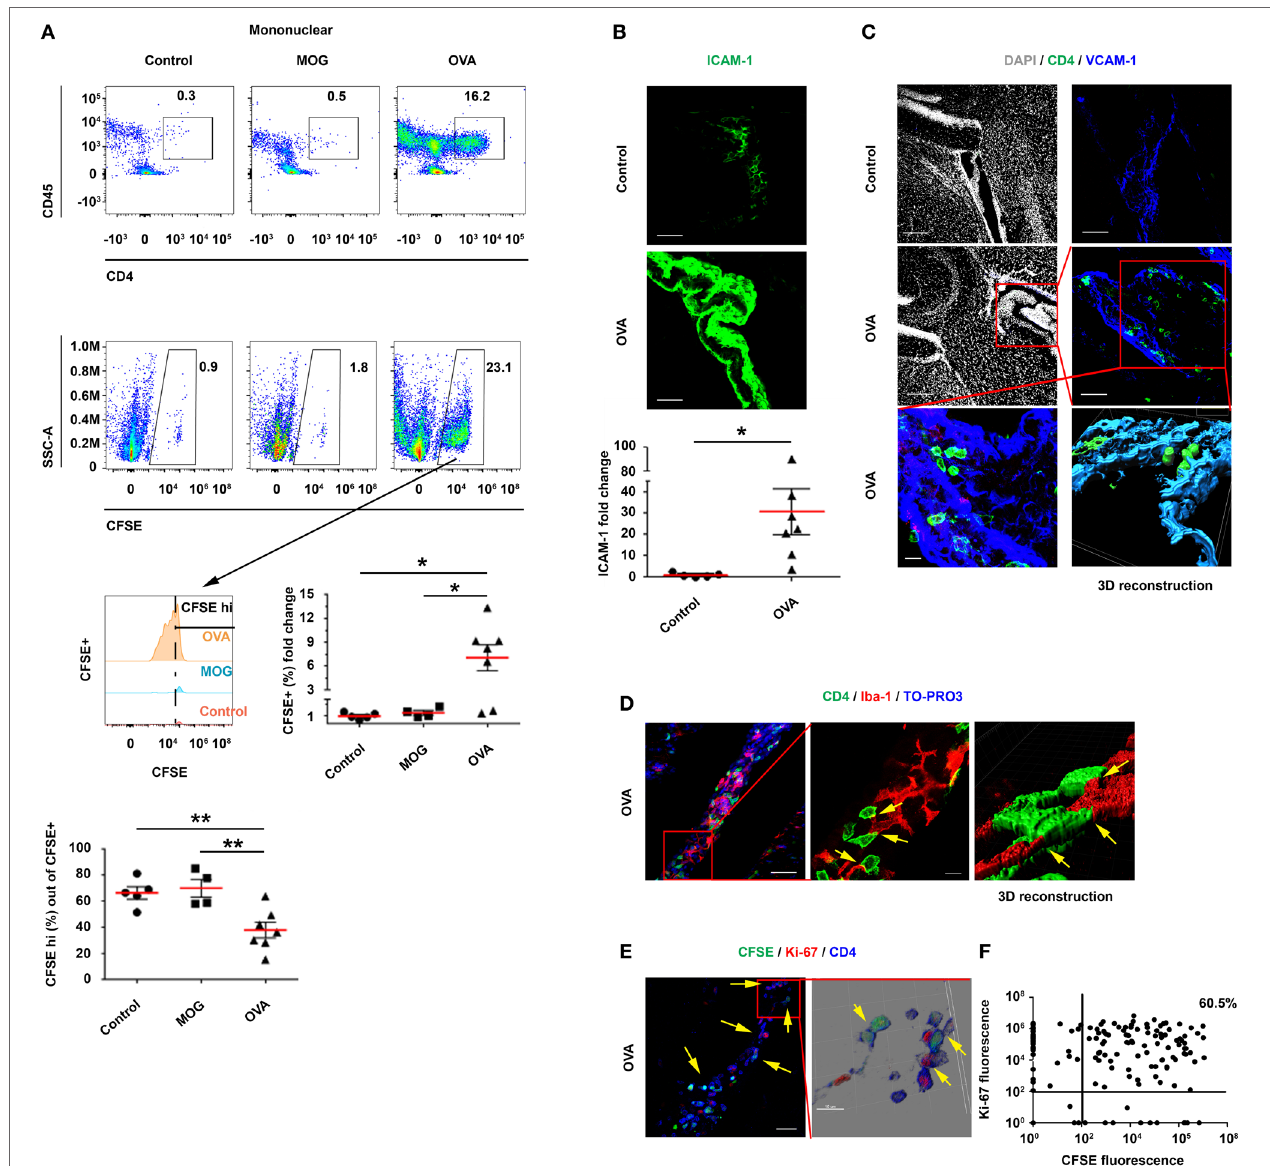
FigUre 4 | Intracerebroventricularly (ICV)-injected, resting ovalbumin (OVA)-specific CD4 T cells undergo proliferation within the choroid plexus (CP) in a cerebrospinal fluid-antigen-dependent manner. Interferon gamma was injected intra-cisterna magna to wild-type mice, either alone or together with OVA 323–339 or MOG 35–55 (as a control peptide). After 24 h, the mice were ICV-injected with carboxyfluorescein succinimidyl ester (CFSE)-labeled, resting OVA-specific Th1 cells, either without a peptide (Control; n = 5), with OVA 323–339 (OVA; n = 7), or with MOG 35–55 [myelin oligodendrocyte glycoprotein (MOG); n = 4]. At 3-day post-injection, the lateral ventricle (LV) CPs of these mice were analyzed by flow cytometry and immunohistochemistry (IHC). (a) Flow cytometry of isolated CPs. The cellular fraction gated on mononuclear cells shows CD45 + CD4 + and CFSE + T cells. (B–F) IHC images of LV CPs obtained from the control and from the OVA-injected mice. (B) Representative brain sections of OVA-injected and control mice, immunolabeled with anti-intercellular adhesion molecule 1 (ICAM-1) (green). The graph shows fold change in ICAM-1 expression in the LV CPs of OVA-injected mice, normalized to the control mice. Scale bars represent 50 µm. (c) Representative brain sections of OVA-injected and control mice, immunolabeled with anti-CD4 (green), anti-vascular cell adhesion molecule 1 (VCAM-1) (blue), and a DAPI counterstained (gray). Scale bars represent 200 µm (top left and middle left panels), 50 µm (top right and middle right panels), and 10 µm (bottom left panel). The bottom right panel shows a 3D reconstruction of z-sections (25.9 µm overall, 0.7 µm/slice) of the framed area. (D–F) Analyses of the interactions between T cells and myeloid cells, and the proliferation of T cells within the CP. (D) Representative brain sections of OVA-injected mice, immunolabeled with anti-CD4 (green), anti-Iba-1 (red), and a TO-PRO-3 nuclear counterstain (blue). The yellow arrows indicate co-localization of CD4 and Iba-1. The right panel shows a 3D reconstruction of z-sections (9.5 µm overall, 0.5 µm/slice) of the framed area. Scale bars represent 50 µm (left) and 10 µm (middle). (e) Representative brain sections of OVA-injected mice immunolabeled with anti-Ki-67 (red) and anti-CD4 (blue). The yellow arrows indicate proliferating CD4 T cells in the CP. The right panel shows a 3D reconstruction of z-sections (22 µm overall, 2 µm/slice) of the framed area. Scale bars represent 50 µm (left) and 10 µm (right). (F) Expression pattern of CFSE and Ki-67 in CD4 + T cells, which were detected in three 40-µm brain sections of a single LV CP from a mouse injected with OVA and with OVA-specific T cells. (a,B) Each symbol represents one LV CP from an individual mouse. Bars represent means ± SEM. * P < 0.05, ** P < 0.01 [ (a) one-way ANOVA, (B) unpaired t test].